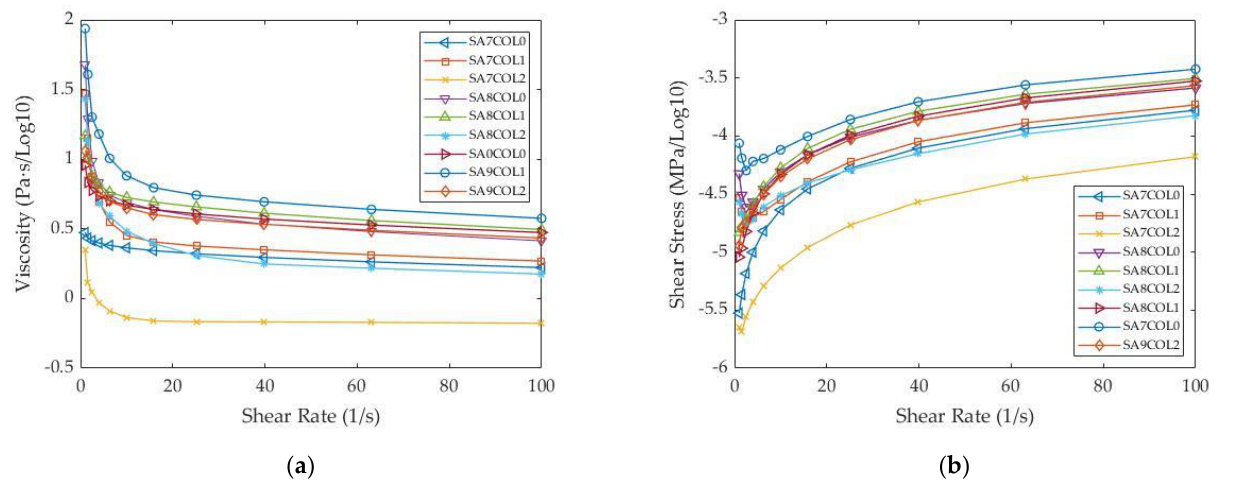
Figure 4. ( a ) Viscosity-shear rate curve; ( b ) Shear stress-shear rate curve.